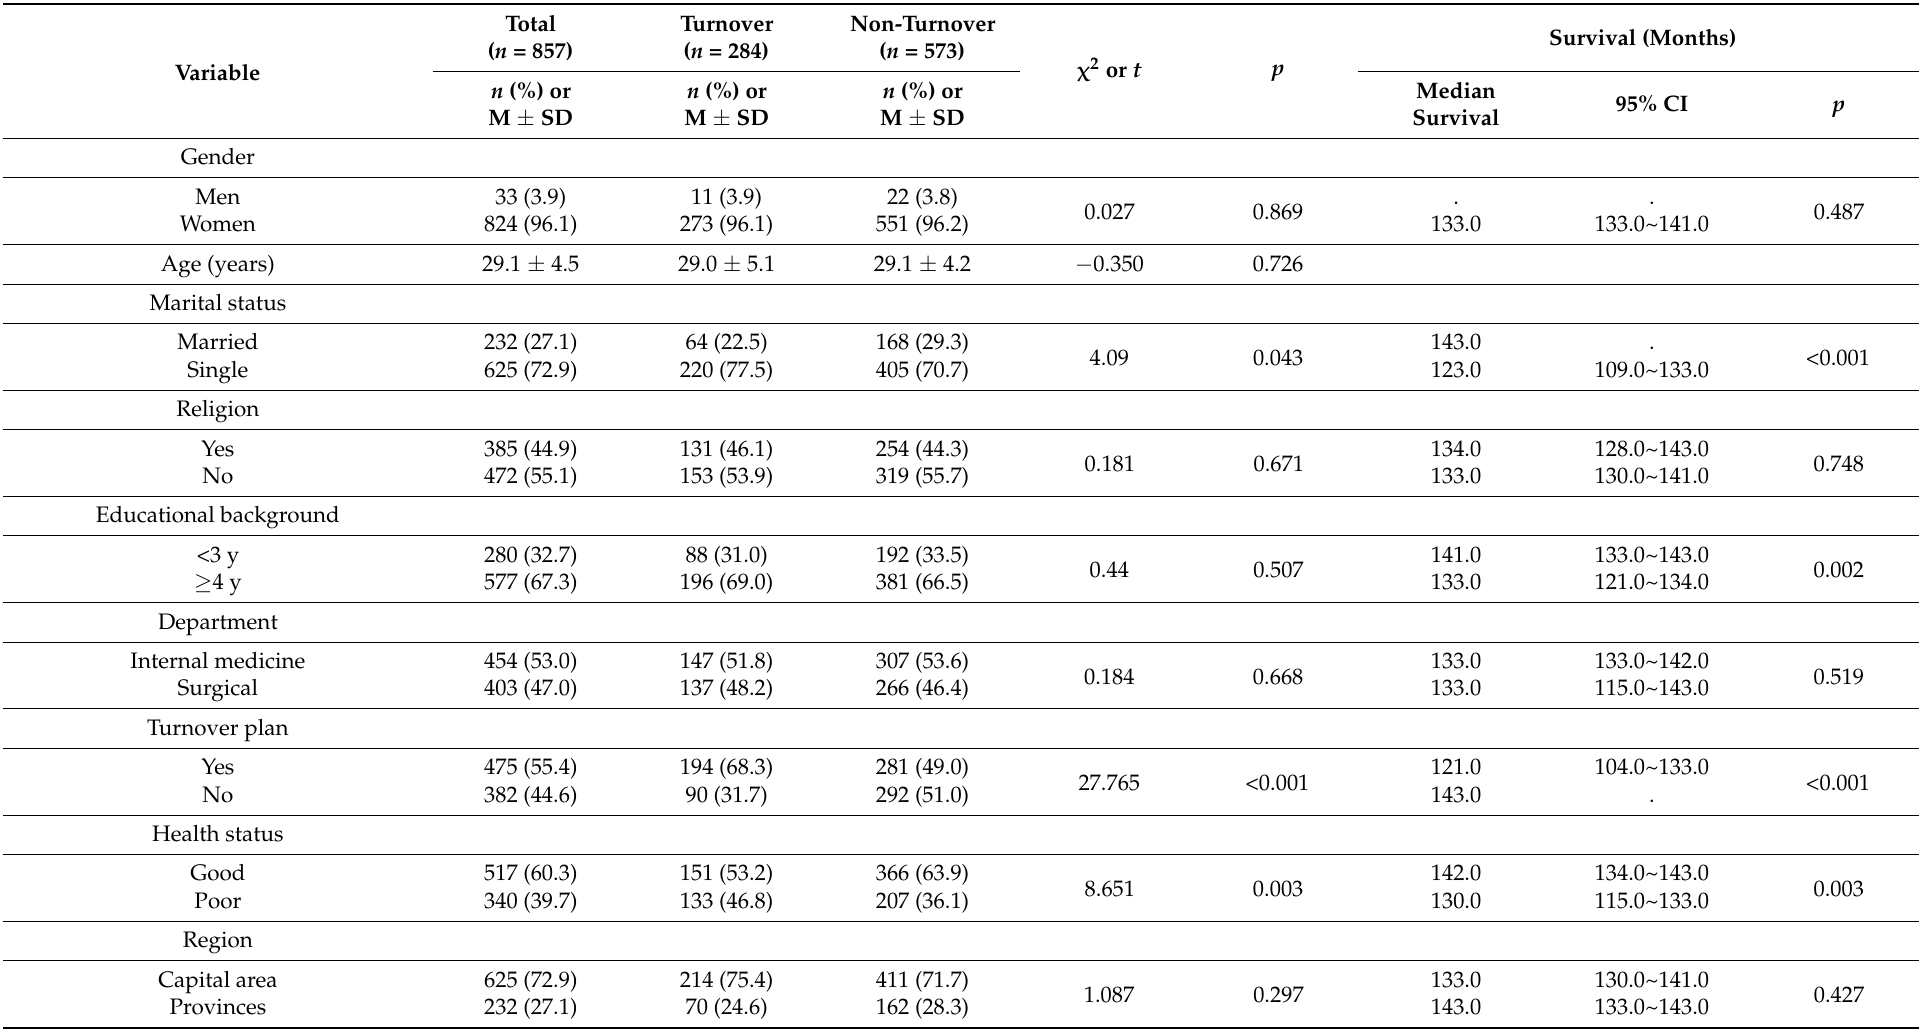
Table 1. Results of an analysis of differences in general characteristics and survival time for turnover vs. non-turnover